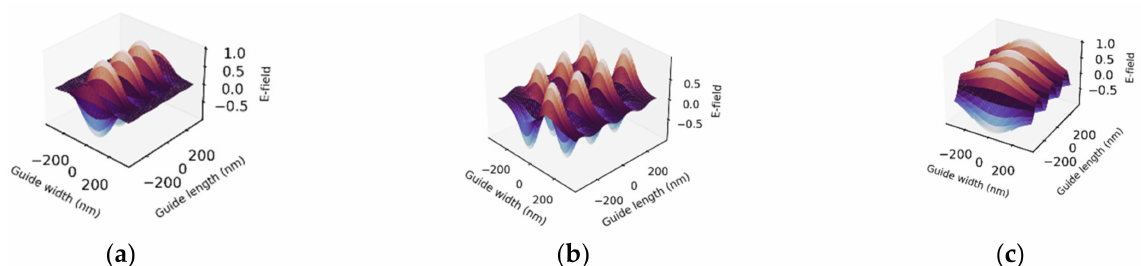
Figure 6. Spatial distribution of TE field in PDMS/PDMS–AAP/PDMS buried waveguide for λ = 340 nm. ( a , b ) m = 0, 1, respectively, with core in trans state. ( c ) m = 0, core in cis state; all higher modes shift down to this mode due to change in refractive index induced by photoisomerization.